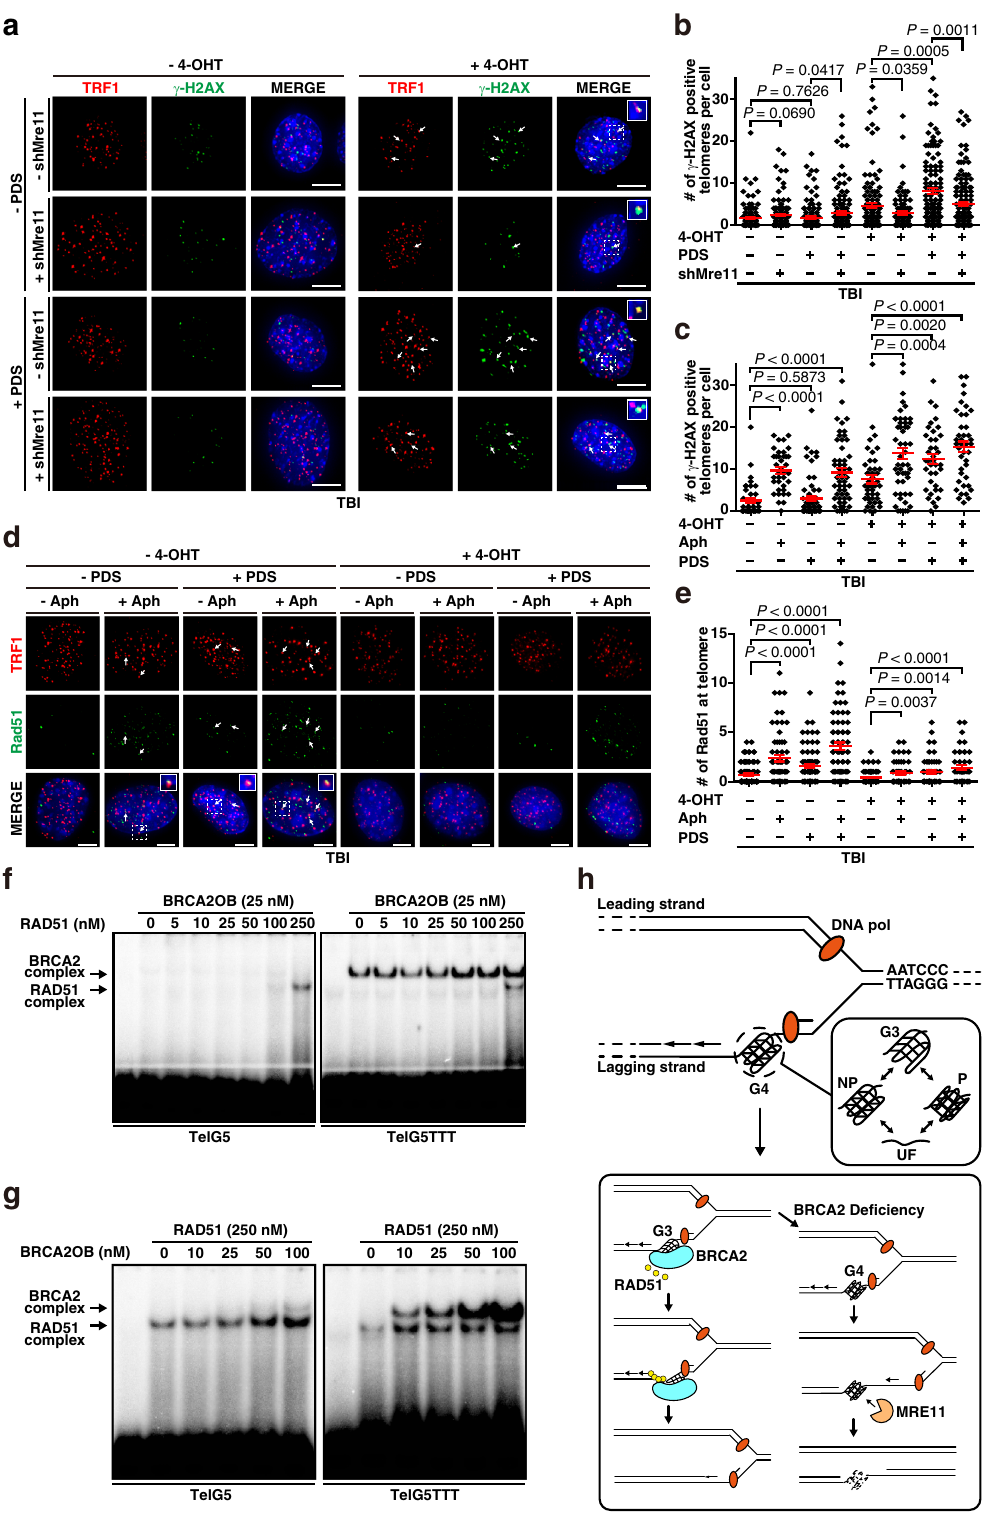
Lengthening of Telomeres). In this case, depletion of Rad51 paralogues in Brca2-abrogated TBI fi broblasts did not alter the ALT activity, indicating that RAD51 paralogues are not required for BIR per se 66 . Nevertheless, as RAD51 is implicated in replication restart and progression under replicative stress 67,68 , we asked whether Rad51 localization at the stalled replication sites was affected by the presence or absence of Brca2.